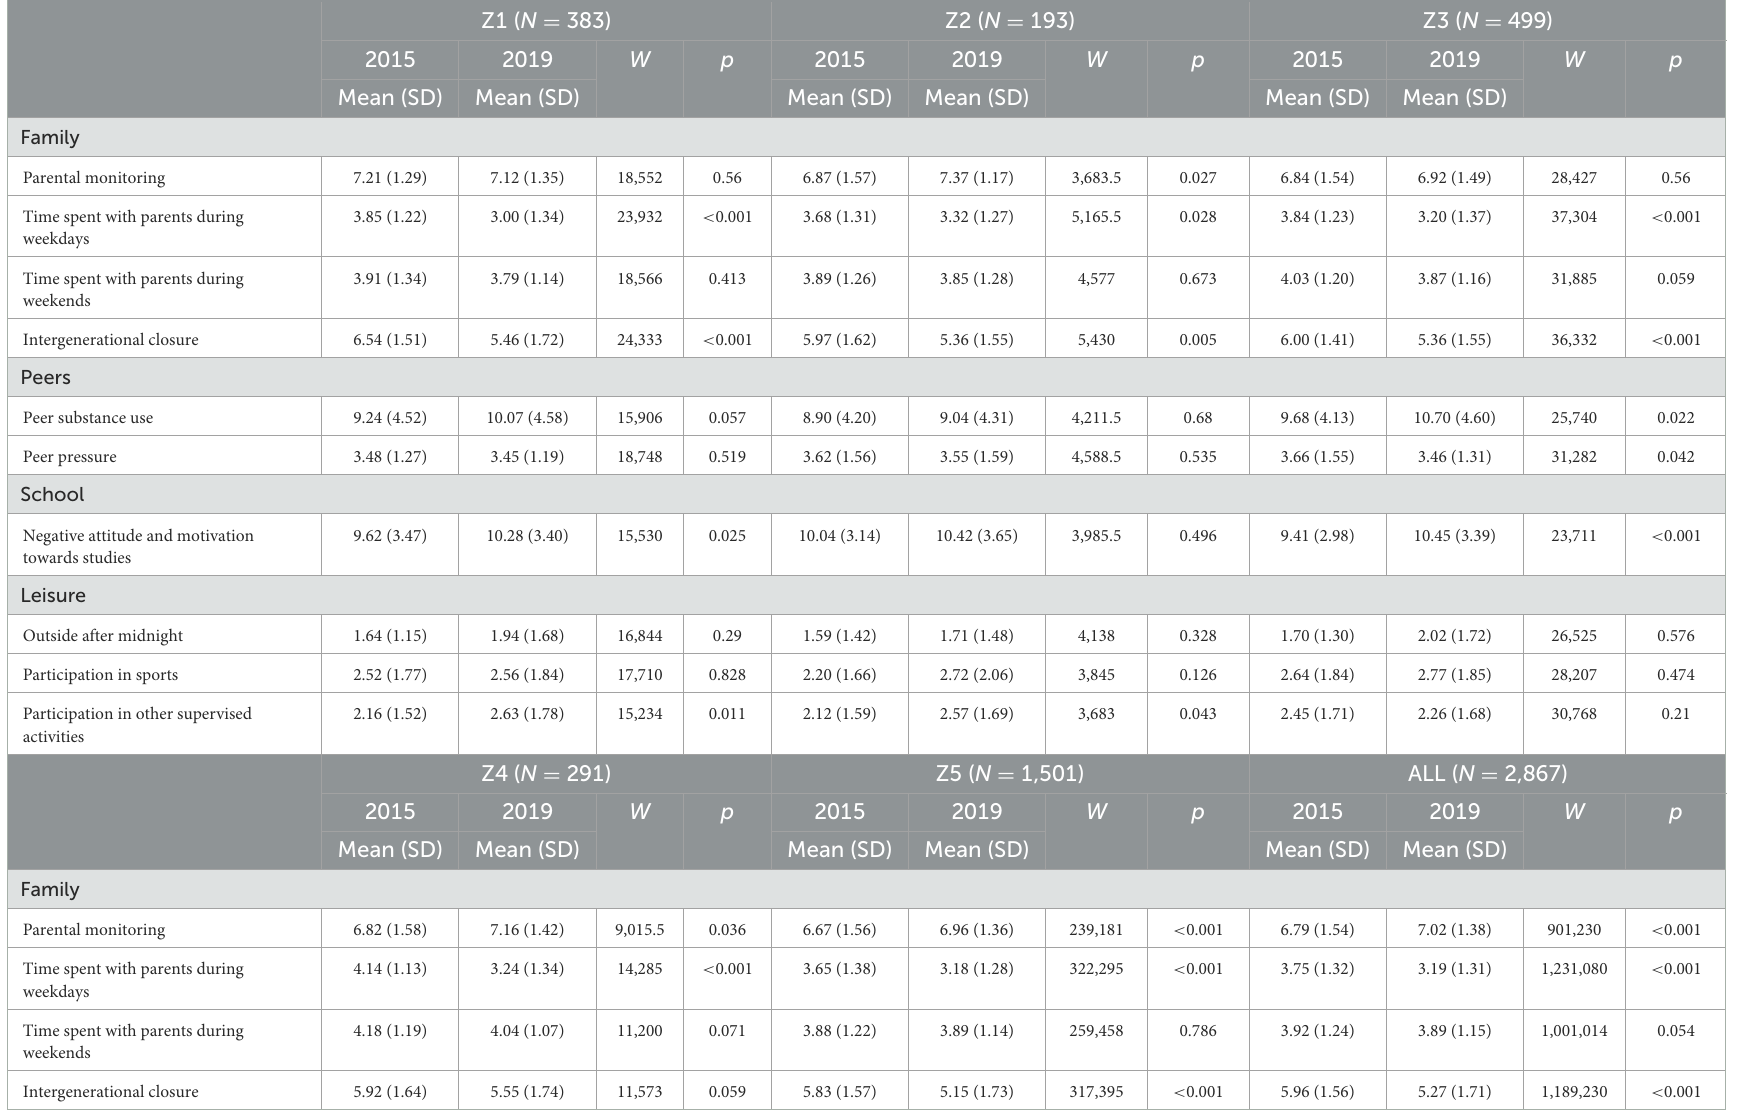
TABLE 2 Comparison of mean scores of IPM risk and protective factors in Tarragona City using Wilcoxon–Mann–Whitney U tests,